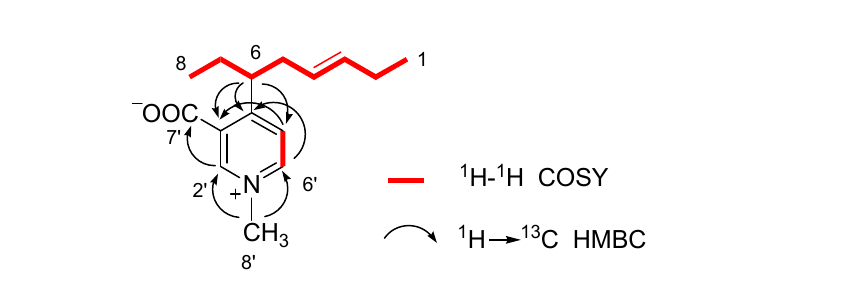
Figure 2. 1 H- 1 H COSY and key 2,3 J